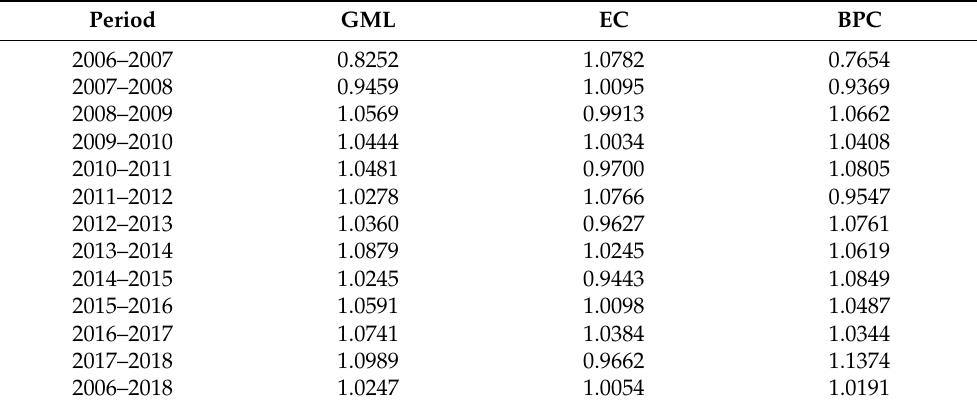
Table 3. GML index and decomposed results of SUE in China’s coastal areas. Period GML